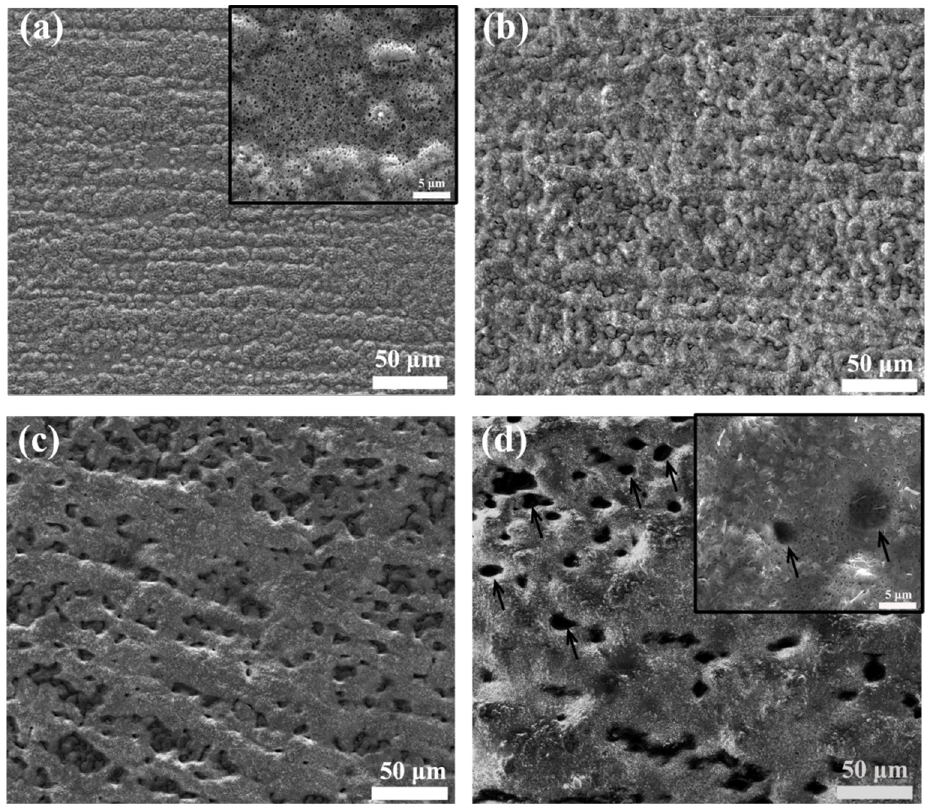
Figure 3. SEM surface morphologies of the Fe-Cr-Zr alloy oxidized in air at 923 K for ( a ) 10 min, ( b ) 20 h, ( c ) 500 h, and ( d ) 1000 h.